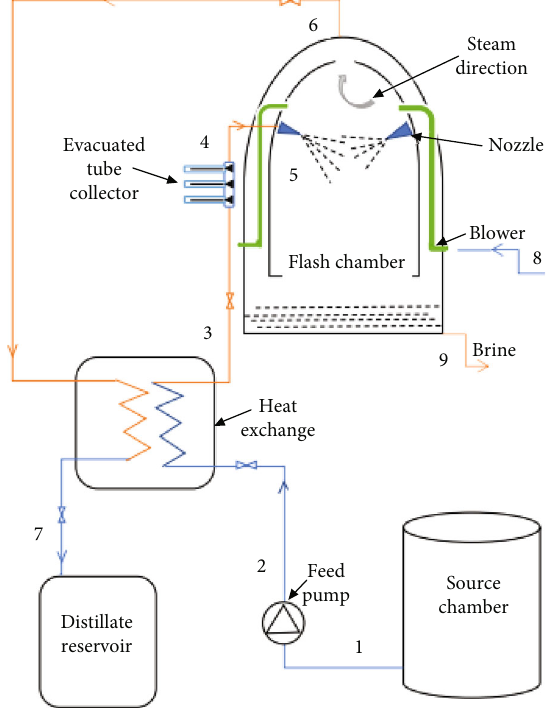
Figure 2: Proposed layout of spray fl ash evaporation